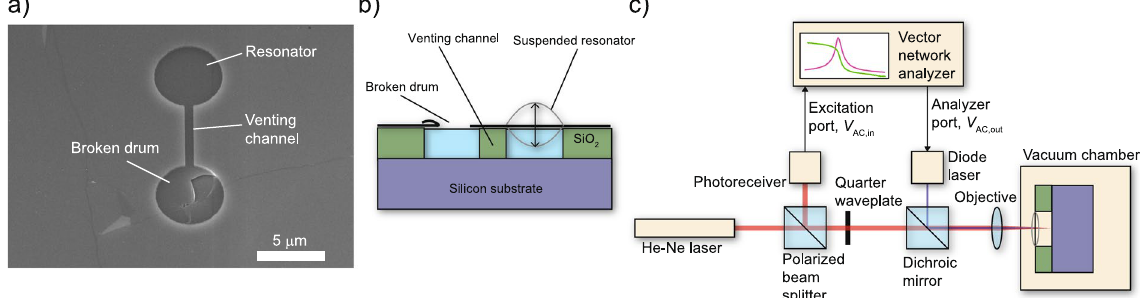
Figure 1. Single layer graphene resonators and the experimental setup. ( a ) Single layer graphene resonator under a scanning electron microscope (SEM). ( b ) Cross section of the device (not to scale). ( c ) Schematic of the measurement setup to actuate the membrane thermally and detect its motion by